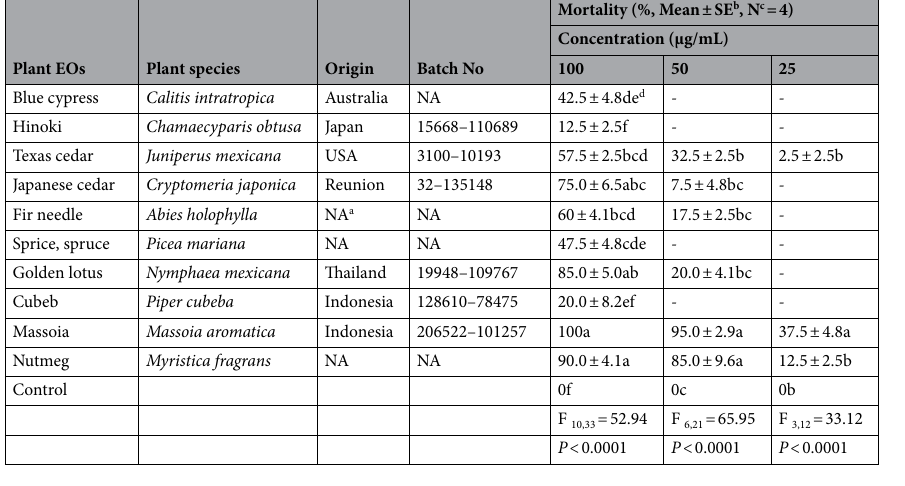
Table 1. Larvicidal activity of 10 EOs against Ae. albopictus . a Not available; b Standard error of the mean; c Replication number; d Means within a column followed by the same letters are not significantly different (Scheffe’s